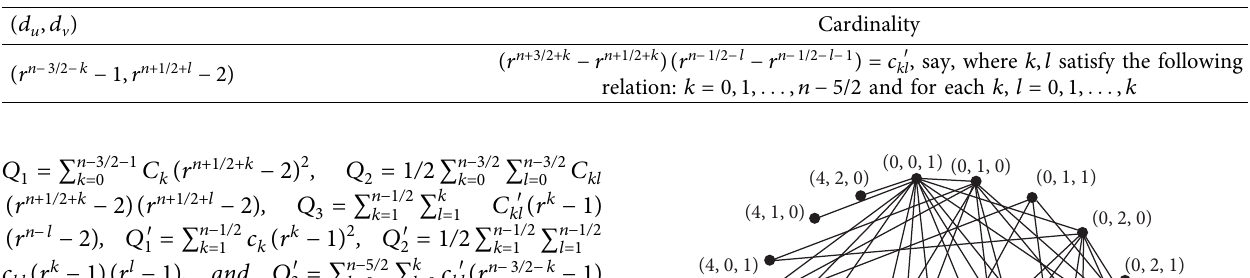
Table 16: Partition of pair of nodes ( u, v ) having distance 2.